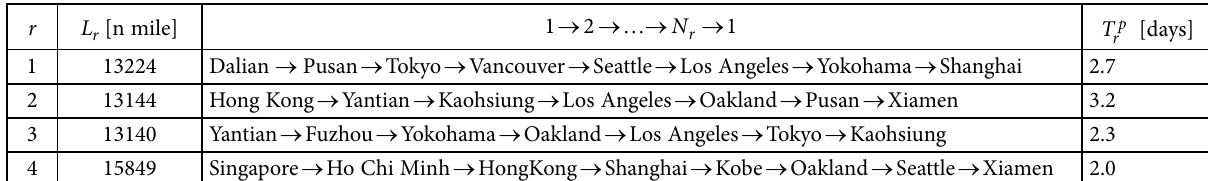
Table 1. Parameters of routes